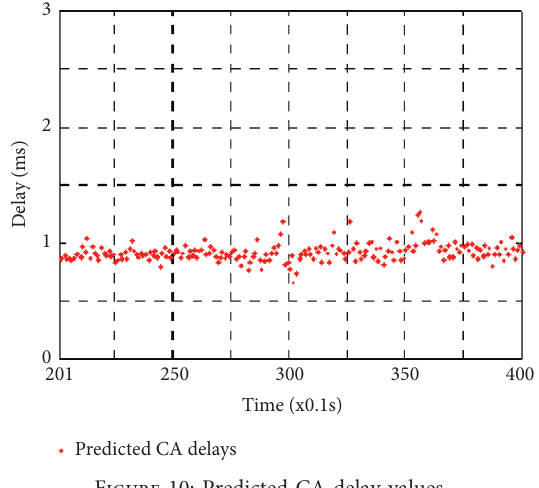
Figure 10: Predicted CA delay